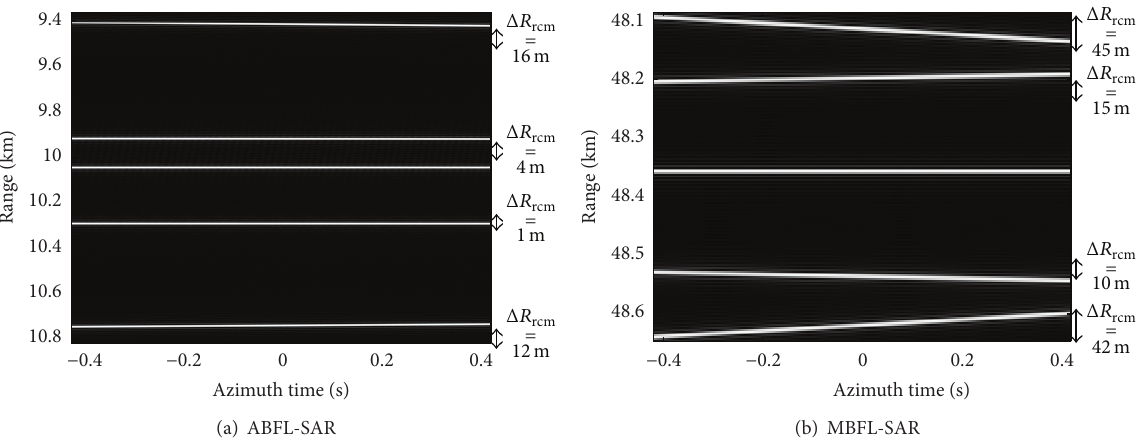
Figure 7: RWR comparison between ABFL-SAR and MBFL-SAR.